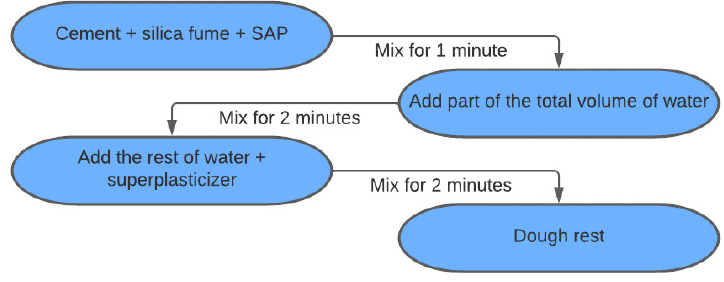
Figure 1. Schematic of the mixing procedure.